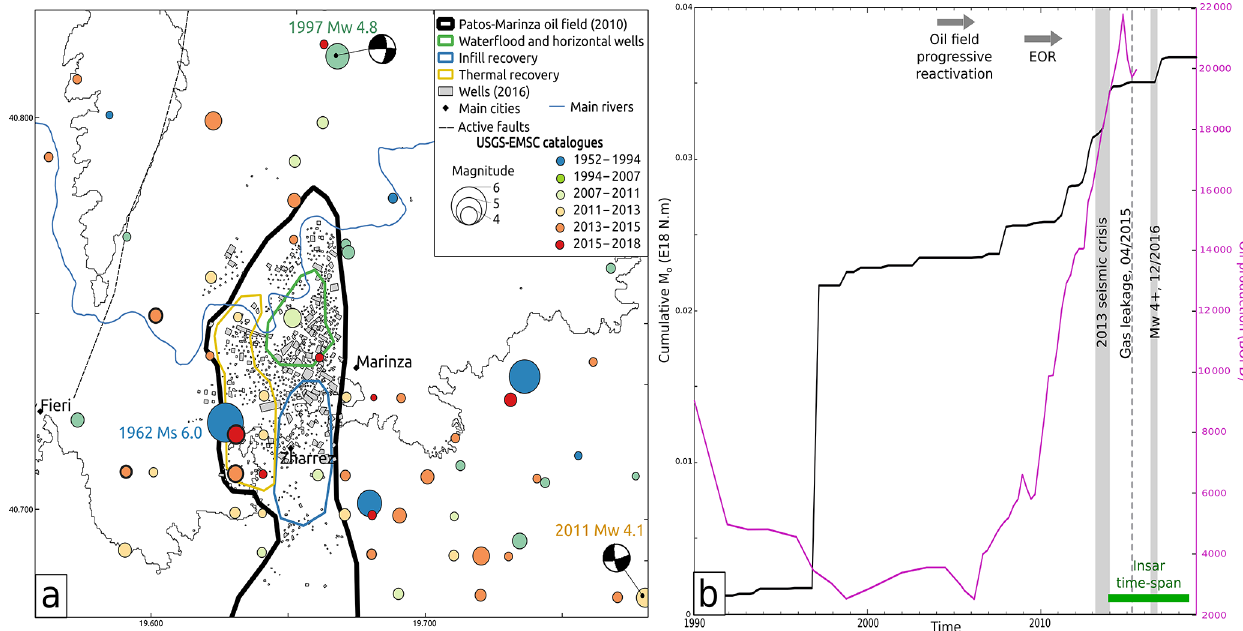
Figure 4. (a) Exploitation extent and recent history of the Patos-Marinza oil field based on BCP (2010). Major wells (gray rectangles of various sizes) have been mapped based on 2016 optical image (Fig. 2a and satellite images from the ©Google Earth database). Seismic events since 1950 are color coded based on their occurrence time and size depending on their magnitude (USGS, 2019; CSEM-EMSC, 2019, before and after 2004, respectively). Earthquakes of the 2013 M w 3 . 5 + sequence are shown by circles contoured in bold black, as well as the 2016 M w 4 + event, all cited in the text. (b) Production evolution in barrels of oil per day (1BOPD ≈ 159L) since 1990 (BCP, 2015) together with the cumulative released seismic moment based on USGS and EMSC catalogues for a small 15km radius region around the center of the oil